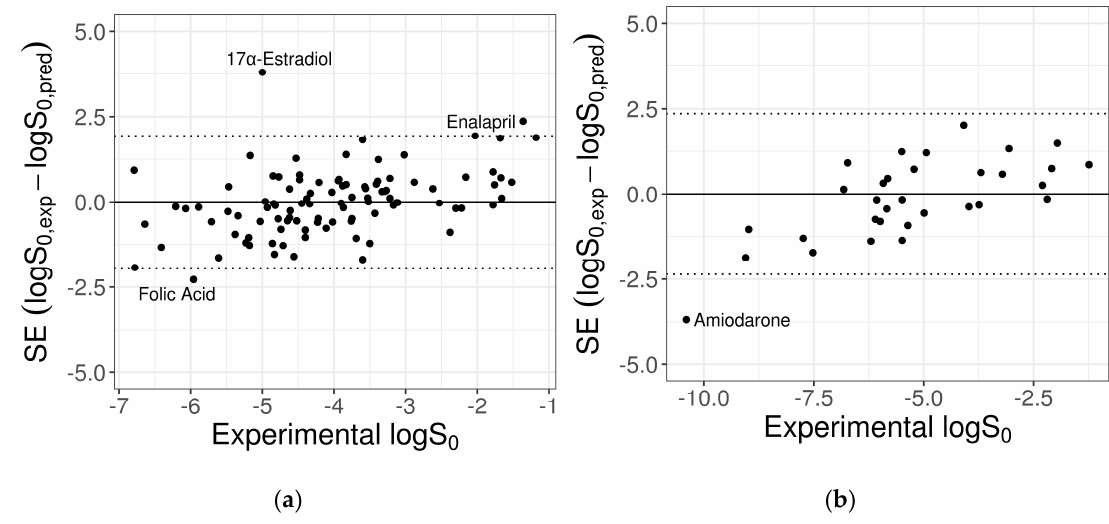
Figure 4. Plots of the SE versus experimental logS 0 for the 100-compound low-variance tight set ( a ) and the 32-compound high-variance loose set ( b ) provided by the SC-2. Dotted lines mark the cut-off threshold for outliers equal to 2×RMSE (test 1: 2.32 log unit; test 2: 2.48 log unit). Names of outlier compounds are displayed.